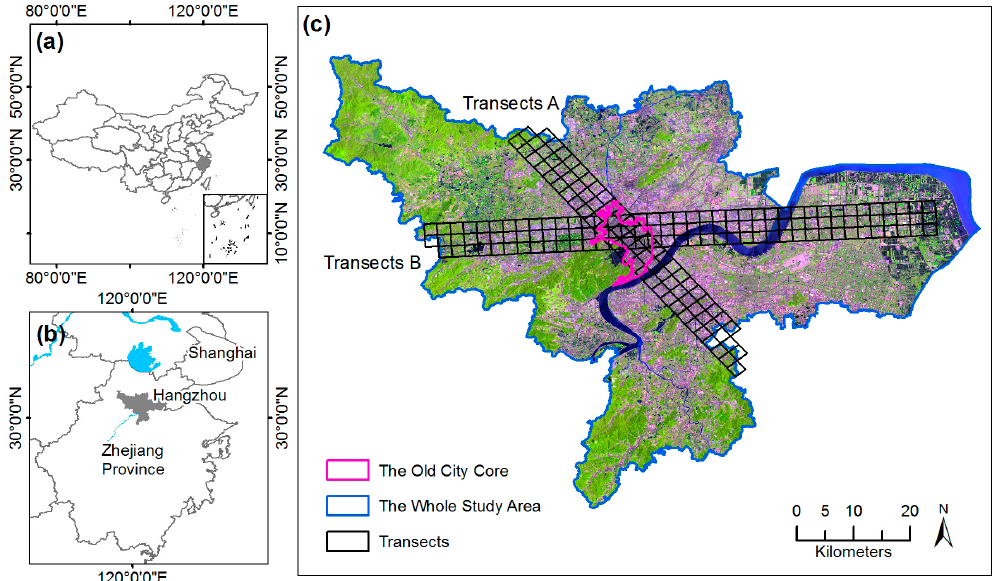
Figure 1. Maps showing ( a ) the location of Zhejiang Province in China; ( b ) the location of Hangzhou City; and ( c ) the study area, Hangzhou city, with the old city core and two study transects labeled.